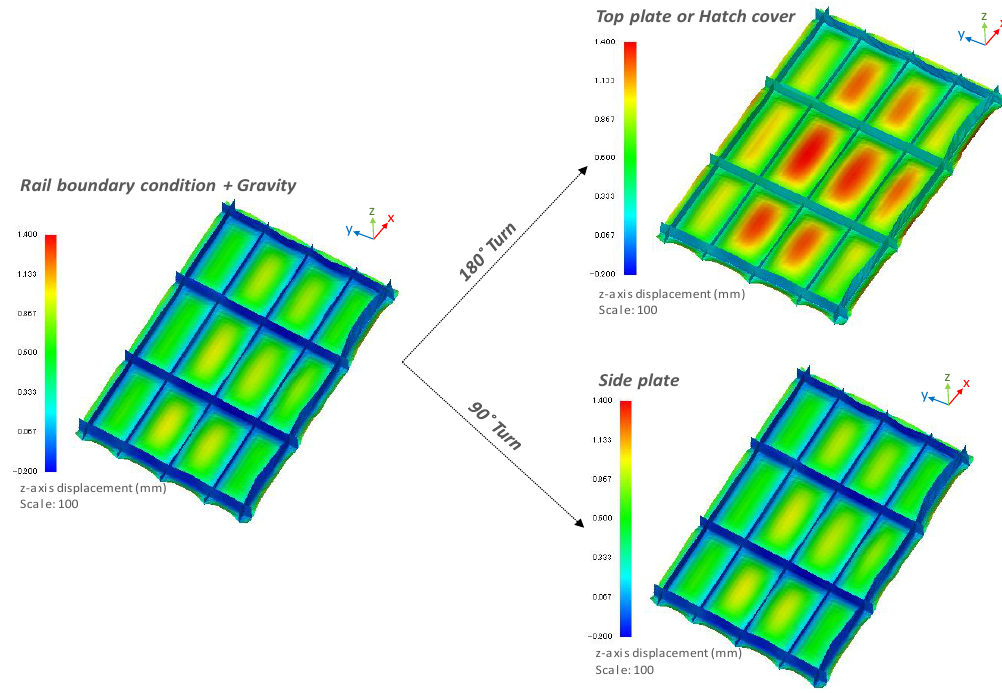
Figure 18. Z-axis displacement of rail boundary condition + gravitational orientation.